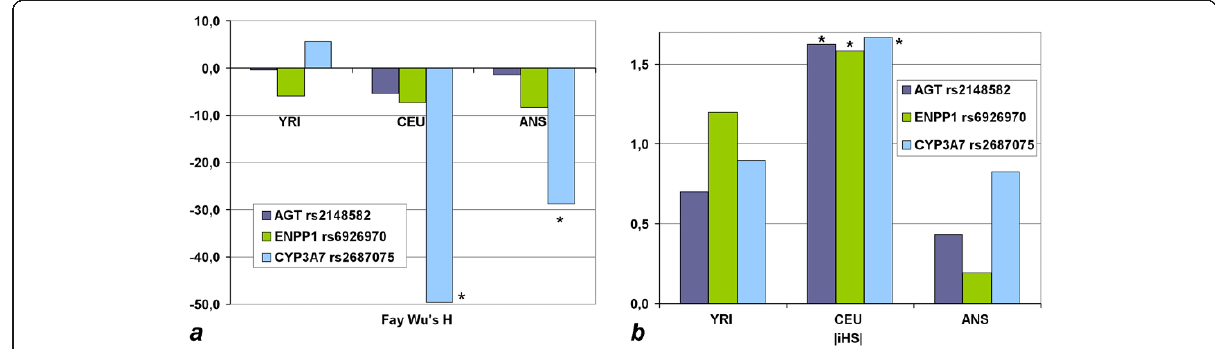
Figure 3 Plot of Fay-Wu ’ s H ( a ) and plot of the Standardized Integrated Haplotype Score (|iHS|) ( b ) . Estimates for the SNPs that were associated with CRC in the Czech population. Comparison of the African (YRI), European (CEU) and East Asian (ANS) population. All estimates refer to SNPs that are linked to the genotyped SNPs because direct values were not available for the genotyped SNPs. * indicate values that provide conclusive evidence for natural selection